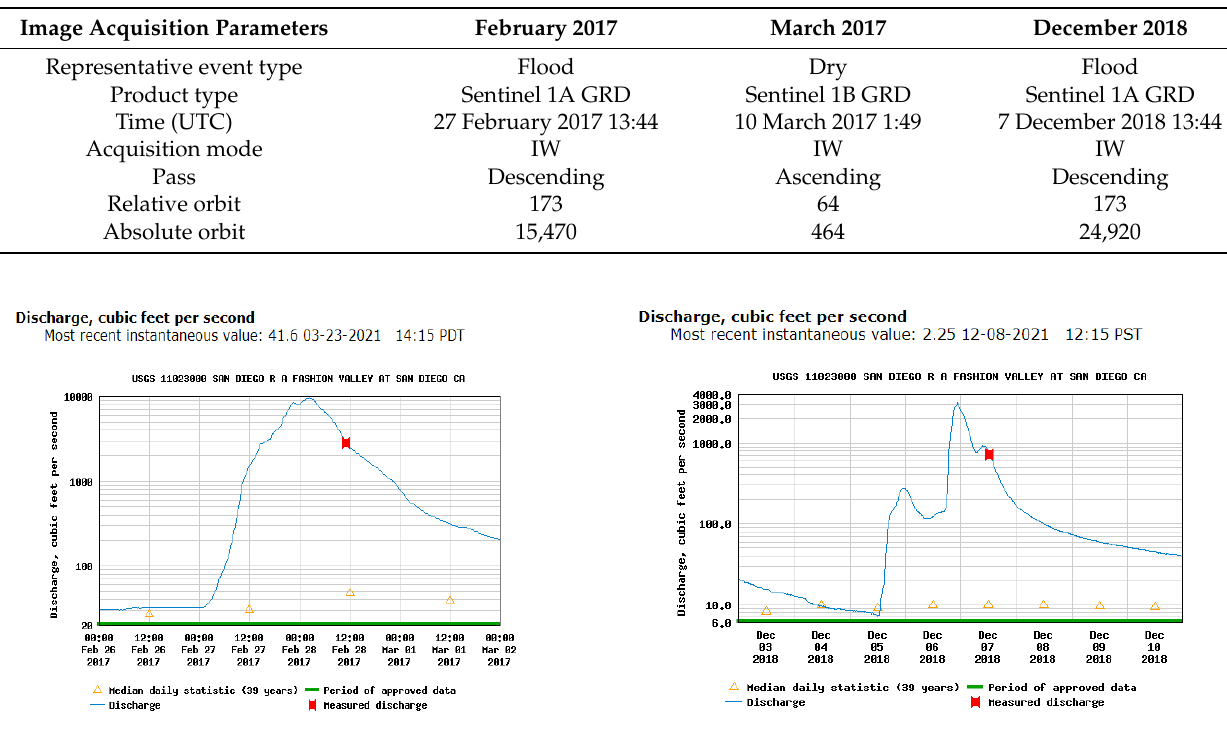
Table 1. Sentinel 1 datasets used in the present research.